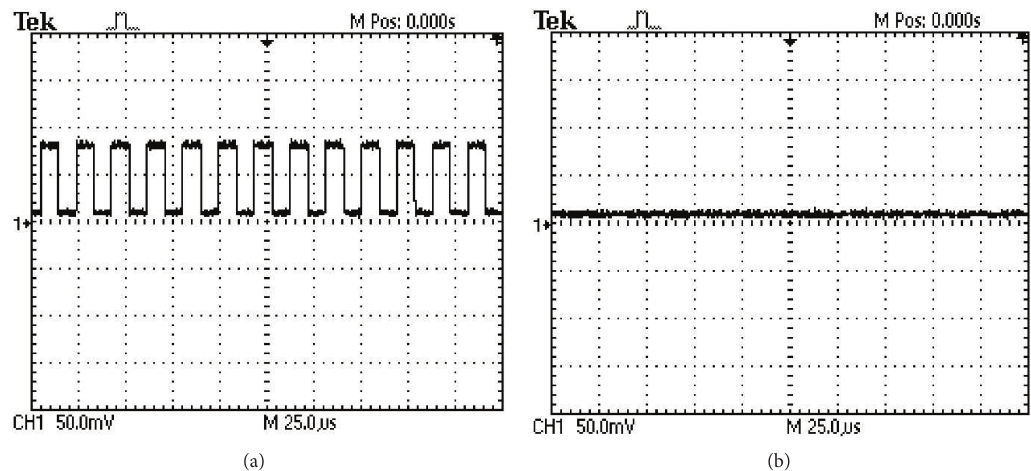
Figure 3: An oscilloscope reading from the gastric serosa prior to the force transducer implantation verified the presence of an activated TIIM pill (a). The sham pills did not have any signal (b). Table 1: Averaged Pearson correlation coefficients (PCCs) of the one-minute gastric motility indices (GMIs) per state per capsule type [17]. PCCs proximal FT-proximal 𝑃 PCCs distal FT-distal 𝑃 Modality State value value Cutaneous GMIs Cutaneous GMIs TIIM capsule